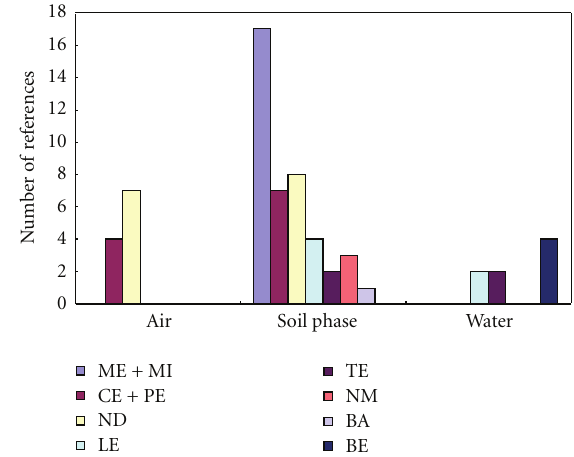
Figure 1: Source frequency of soil metal pollution data across di ff erent environmental matrices and with respect to di ff erent industry types ( n = 61 references for comparison: refer to Table 1 for